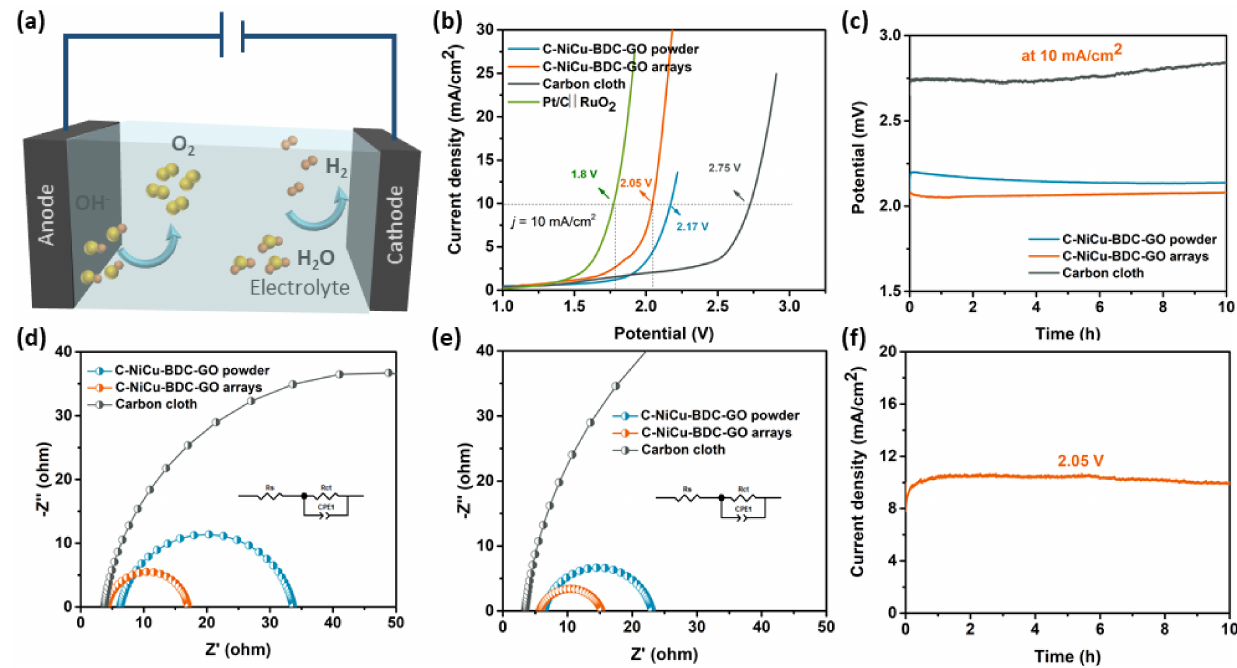
Figure 5. Electrochemical measurements in the two-electrode system. ( a ) Schematic illustration of the two-electrode system for overall water splitting. ( b ) LSV curves of the C–MOF arrays, powder, and CC working as both the cathode and anode electrode. ( c ) Stability test at 10 mA/cm 2 of the C–MOF arrays, powder, and bare CC. ( d , e ) Fitted EIS spectra of corresponding catalysts at the constant potential (the current density of the relevant potential was 10 mA/cm 2 ) and the constant current density (10 mA/cm 2 ), respectively. ( f ) Stability test of the C–MOF arrays at 2.05 V for 10